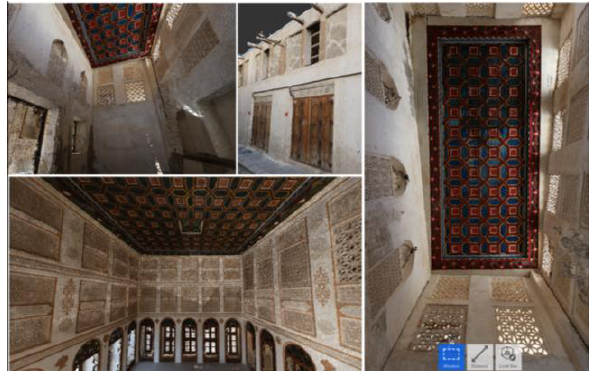
Figure 10 Examples of the developed consolidated pointcloud. Software employed Agisoft Photoscan and Autodesk Recap. Images source: Authors and BACA staff.